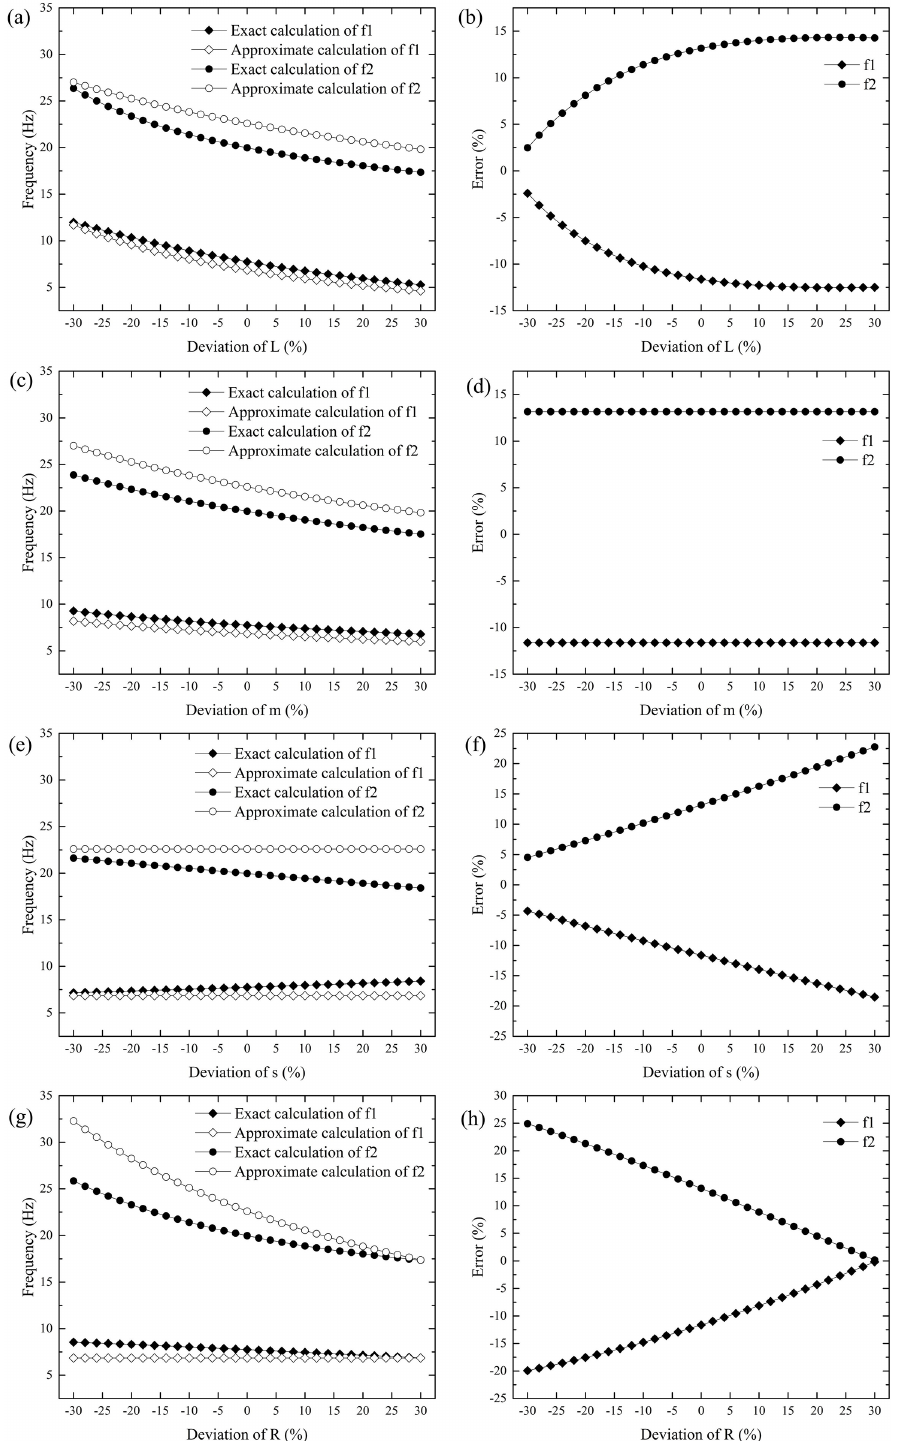
Figure 4. The exact and approximate calculation results of the two natural frequencies of the vibration damper with the variations of its structural parameters: calculation results (a) and approximate calculation errors (b) when L changes; calculation results (c) and approximate calculation errors (d) when m changes; calculation results (e) and approximate calculation errors (f) when s changes; calculation results (g) and approximate calculation errors (h) when R